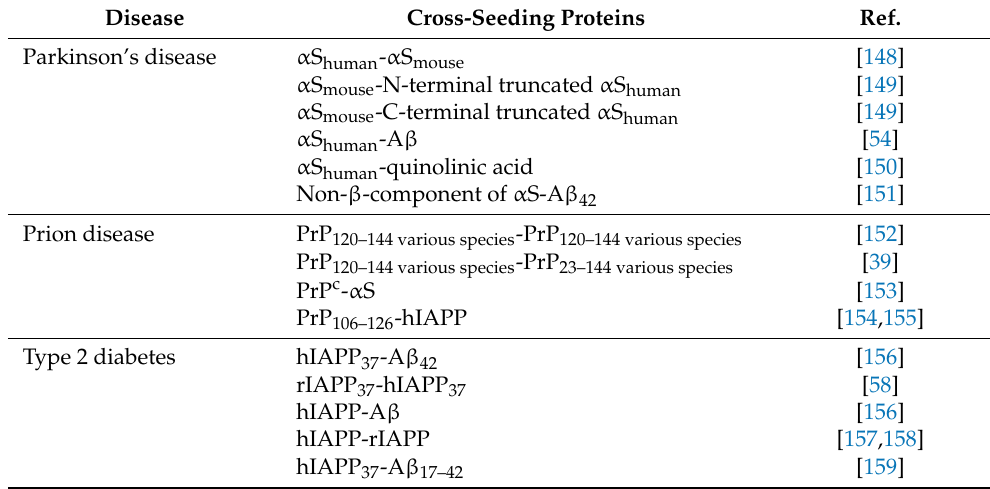
Table 1. Cont. Disease Cross-Seeding Proteins